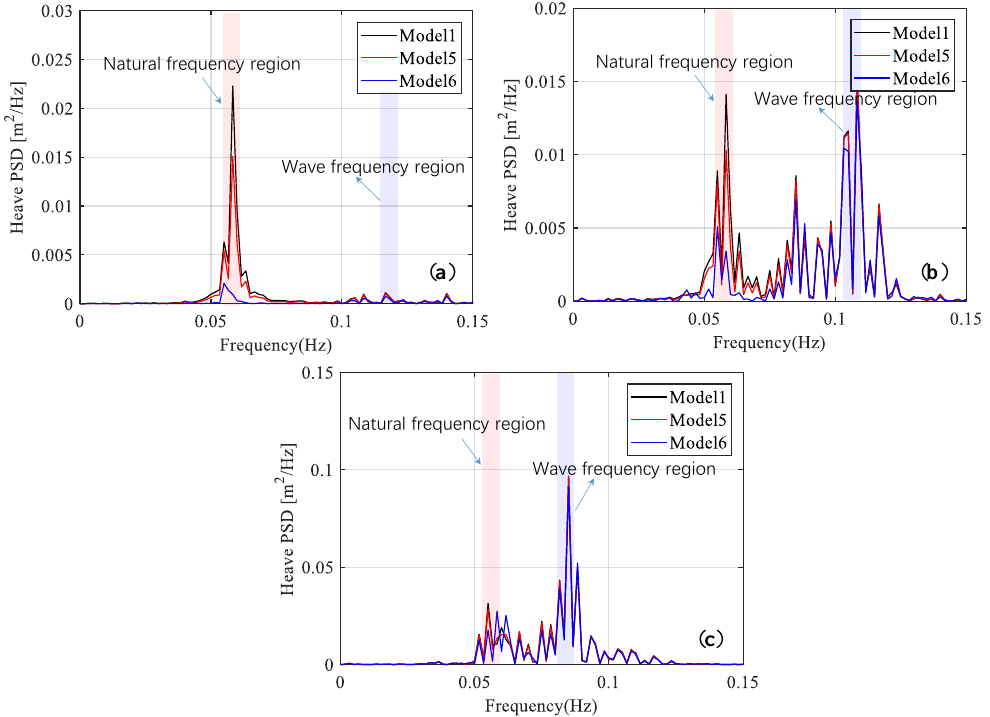
Figure 18. Frequency domain curves of the heave PSD of the inclined upper column models: ( a ) LC4; ( b ) LC5; and ( c ) LC6.